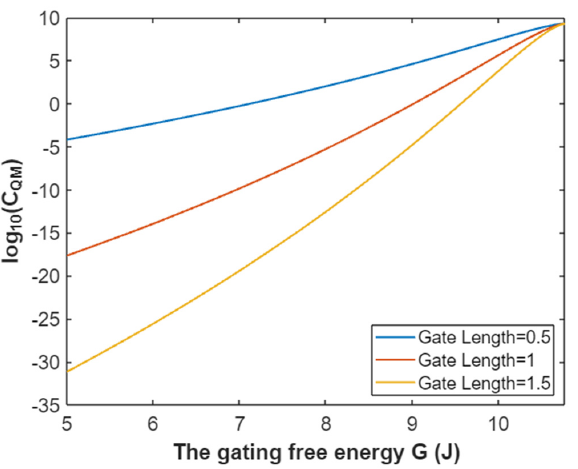
Figure 15. The relationship between gating free energy and the common logarithm of quantum membrane conductance of extracellular sodium ions at membrane potential of 0.087 V and over a gating free energy range from 5 J to 10.77 J.